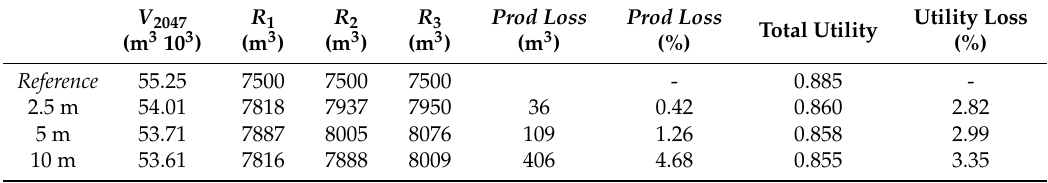
Table 4. Effect of applying the optimization solutions based on inaccurate forest inventory data to